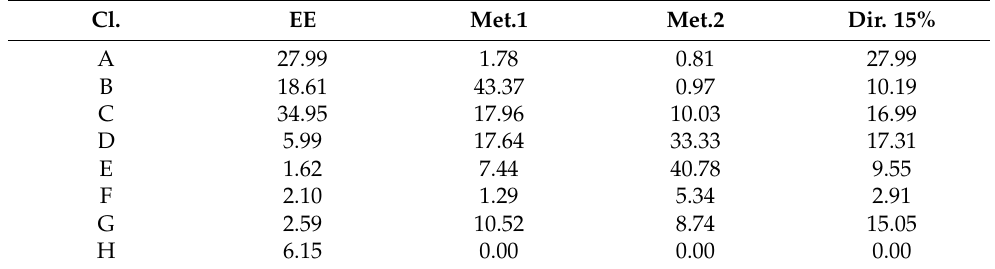
Table A6. EPC certificates % per energy class, as allocated by the different methods,